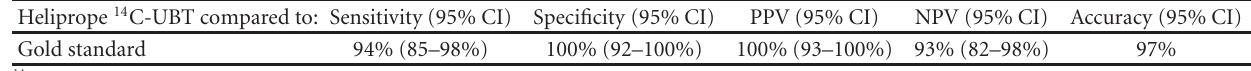
Table 2: Diagnostic performance of Heliprobe 14 C-UBT against gold